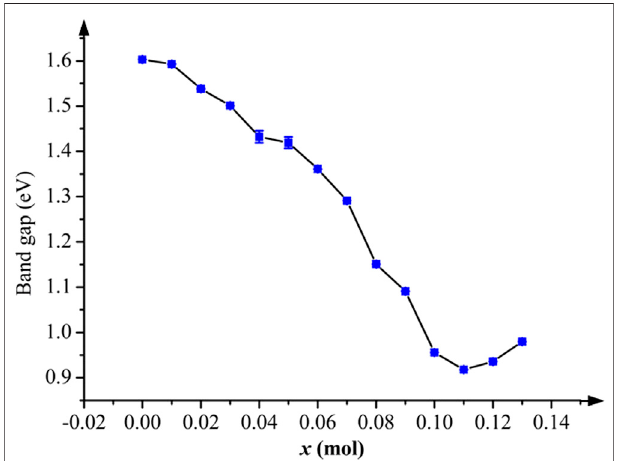
FIGURE2| The bandgap ofLi 1.0- x Al x Ni 1/3 Co 1/3 Mn 1/3 O 2 witherror bars. The curve goes down generally, which indicates its conductivity is enhanced effectively after Al doping.